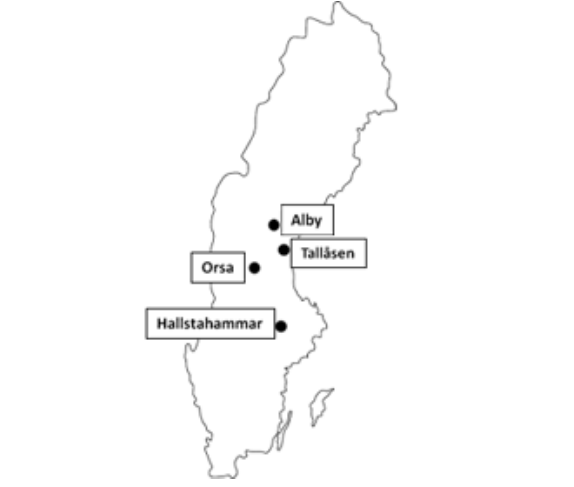
Fig. 1. Locations in Sweden of the dam removal controversies considered in this